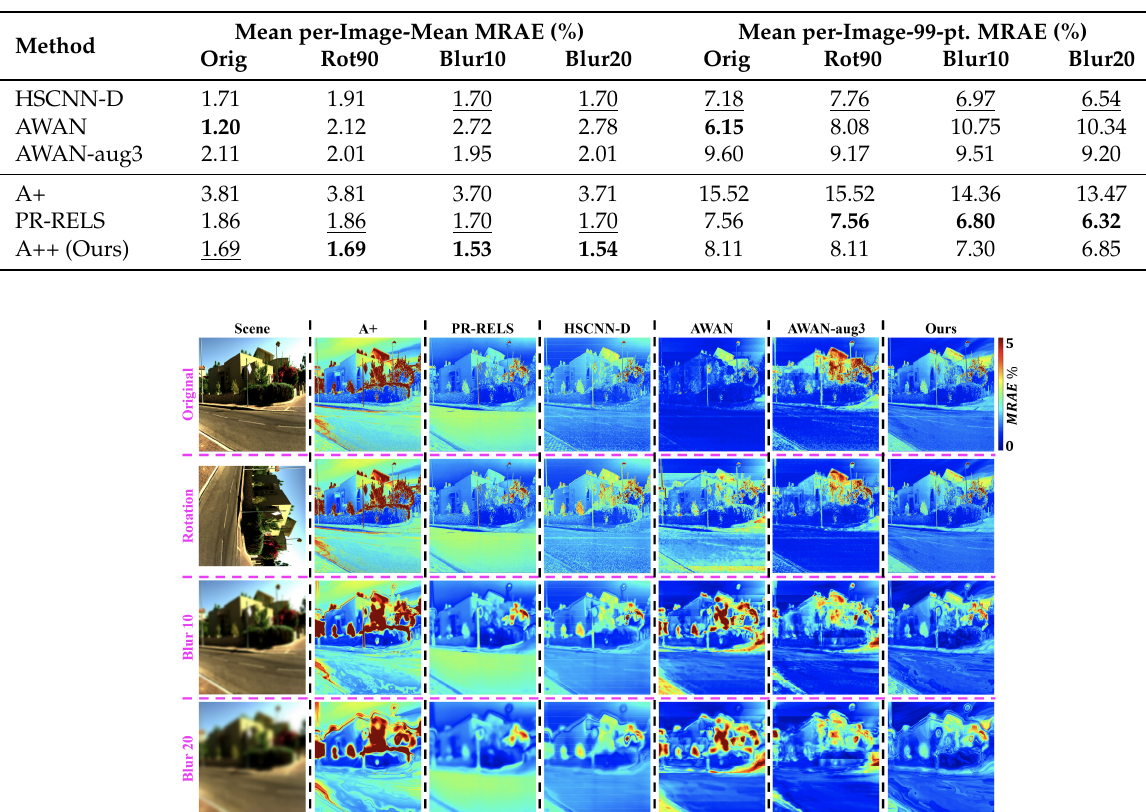
Table 4. The mean and 99-percentile hyperspectral image reconstruction error in MRAE, testing with the original test-set images ( Orig ), the 90 ◦ -rotated test-set images ( Rot90 ), and the Gaussian blurred images with σ = 10 ( Blur10 ) and σ = 20 ( Blur20 ). The best methods in each experiment are in bold font, and the second bests are underlined.